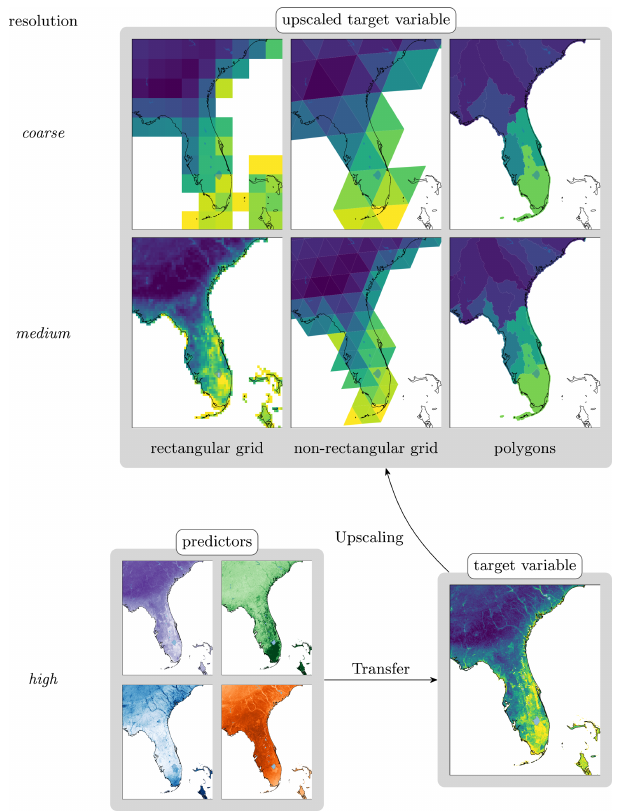
Figure 1. Example application of MPR deriving porosity based on SoilGrids250m (Hengl et al., 2017) variables (bulk density, organic matter, clay and sand content) in Florida, USA